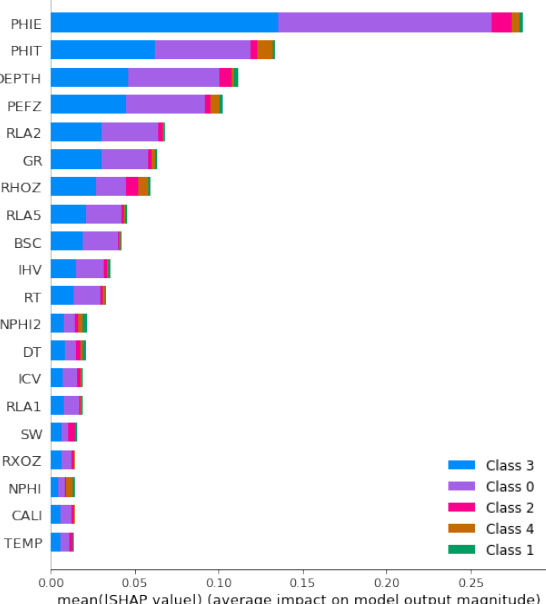
Figure 9. Importance factor of Random forest model for each input variable for the